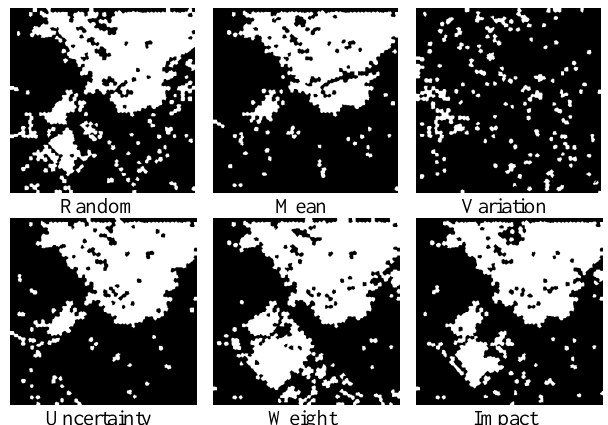
Figure 8. The change detection results for different query strategies with active learning.